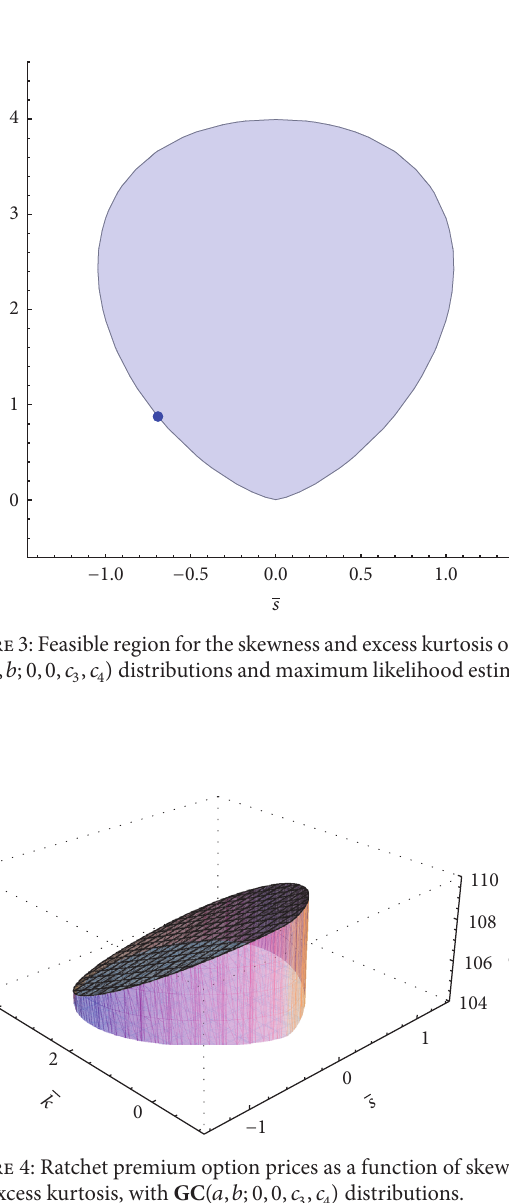
excess kurtosis 𝑘 . The risk-free rate is 3%, the dividend rate is 2%, and the term is 7 years. The martingale condition (89) 󸀠 so that (89) is satisfied. must hold and so 𝑎 is replaced with 𝑎 ( N.B. The Black-Scholes model corresponds to 𝑐 3 = 𝑐 4 = 0 , in which case 𝑎 󸀠 = (𝑟 − 𝛿)𝑇 − 𝑏 2 /2 ; this is −0.004193 with the values of 𝑟 , 𝛿 , and 𝑏 we are using and 𝑇 = 1 .)